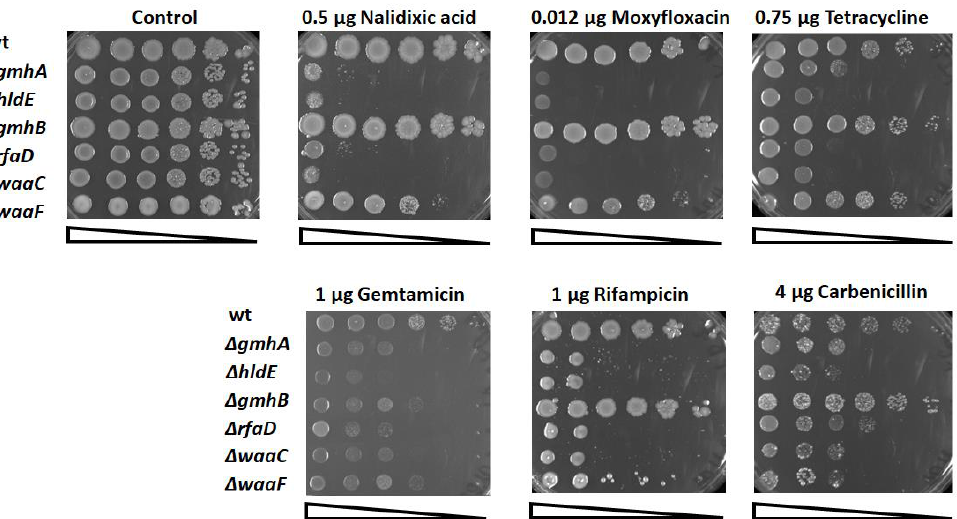
Figure 3. Determination of the sensitivity of strains containing deletions in the gmhA, hldE , gmhB , rfaD , waaC , and waaF genes to various groups of antibiotics. Cells were spotted on LB agar plates in serial 10-fold dilutions and incubated at 37 °C for 24 h.